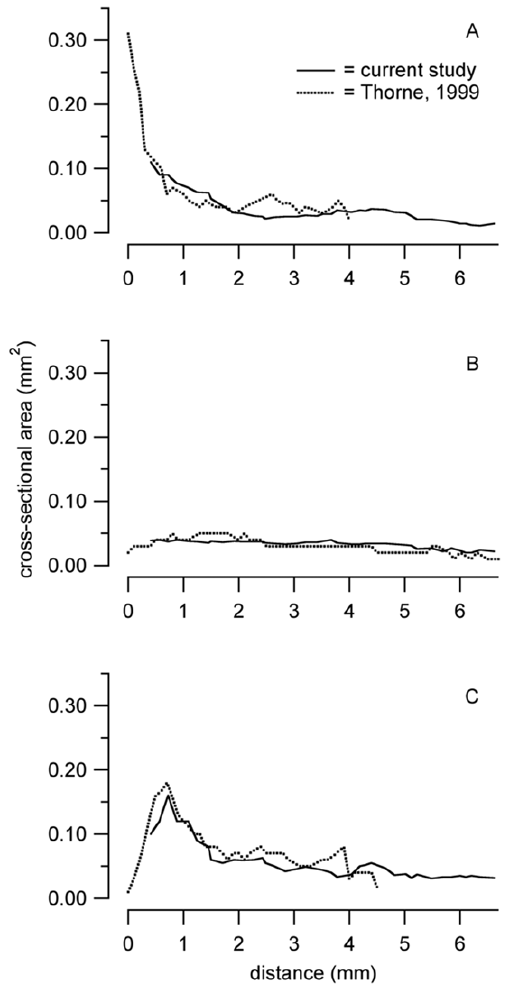
Figure 4. Measurements obtained from the reconstruction. Cross-sectional area as a function of distance from the base of the mouse cochlea are shown by the solid line for A: scala vestibuli, B: scala media, and C: scala tympani. Cross sectional areas decreased from base to apex for scala vestibuli and for scala tympani. The cross sectional area of scala tympani revealed a distinct maximum at about 0.16 mm from the base. Values for scala media cross sectional area vary little. The changes in cross sectional area of scala media are small. For all scalae the cross sectional area measurements, which were obtained in the present study, are in agreement with previously published data [8] and are shown by the broken lines.